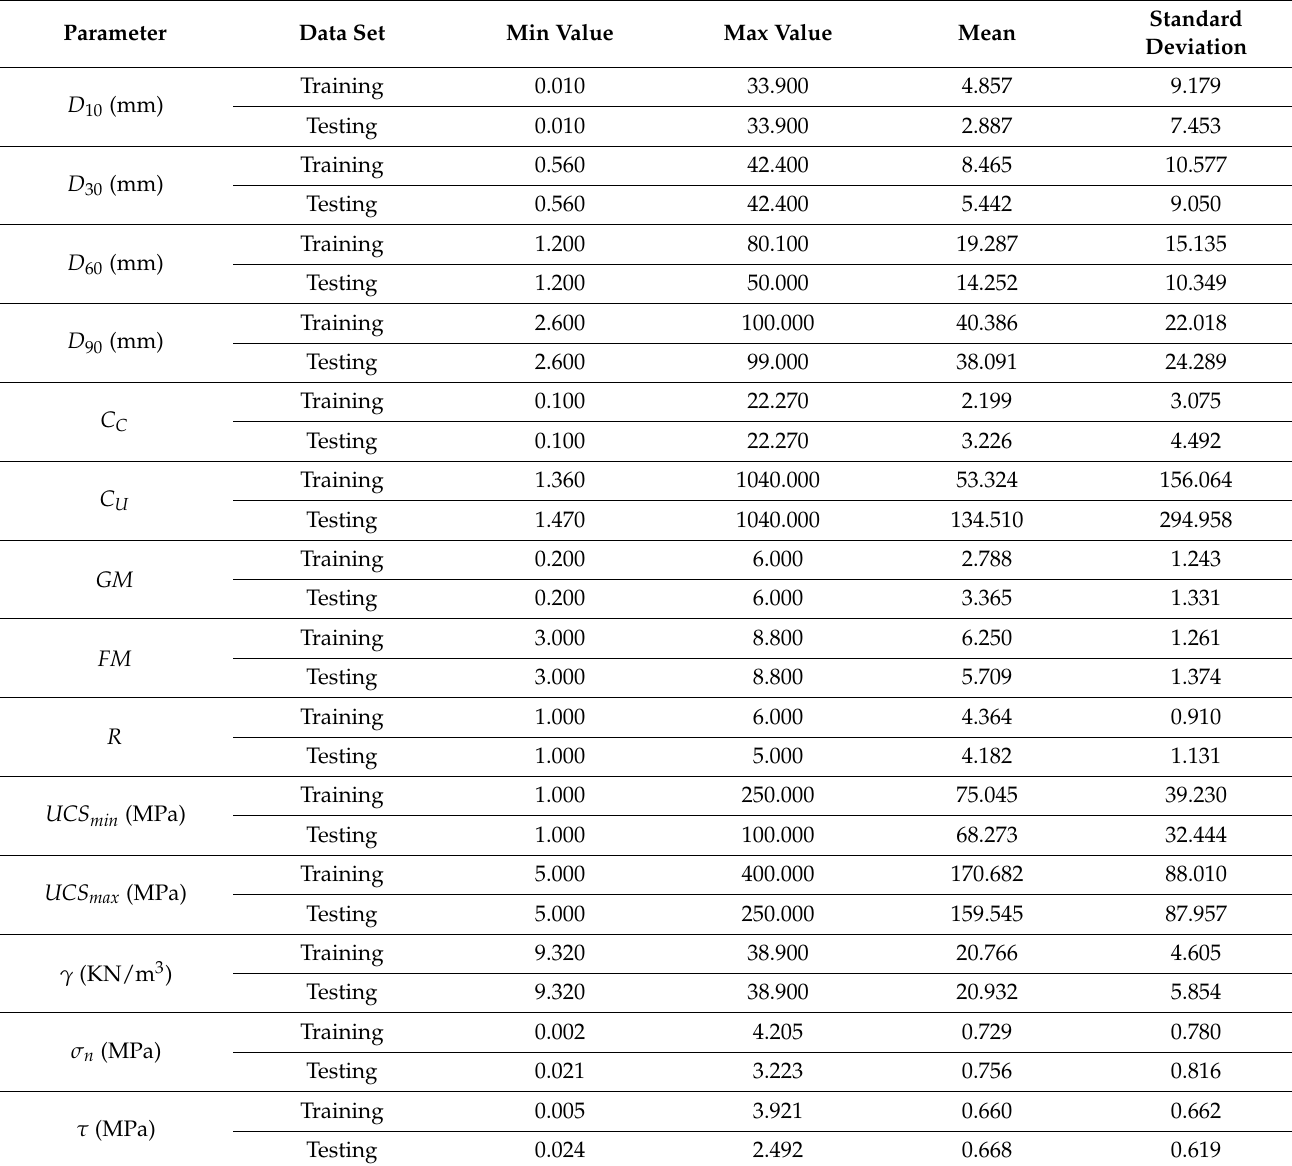
Table 2. Statistical parameters of the training and testing data